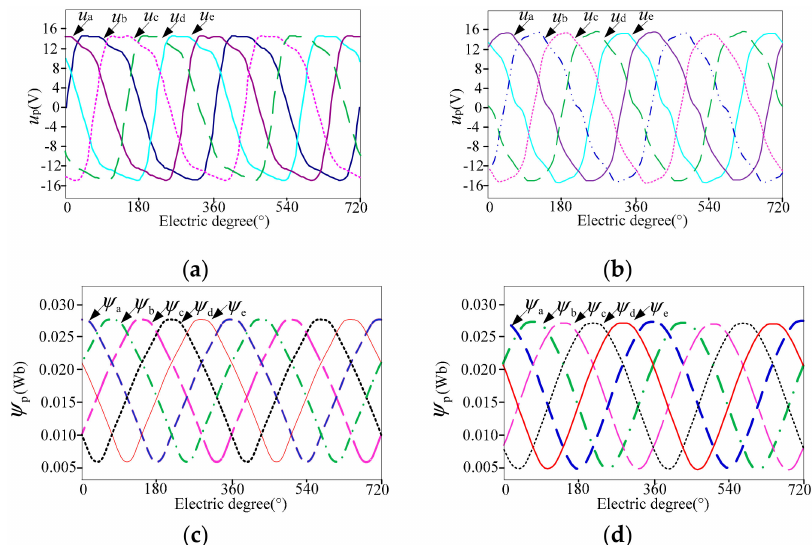
Figure 2. The simulated electromotive force (EMF) and flux linkage. ( a ) Phase EMF of 30 / 24-pole. ( b ) Phase EMF of 20 / 16-pole. ( c ) Phase flux linkage of 30 / 24-pole. ( d ) Phase flux linkage of 20 / 16-pole.